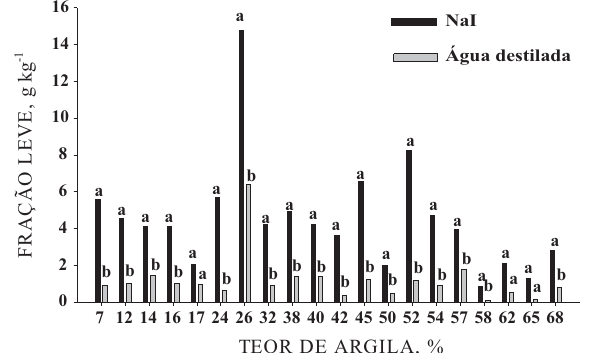
Figura 1. Massa da fração leve (FL) da matéria orgânica do solo (g kg -1 de solo) extraída com iodeto de sódio (NaI) e água destilada. Letras iguais para cada solo com o mesmo teor de argila não diferem quanto aos teores de carbono a 5 % pelo teste de